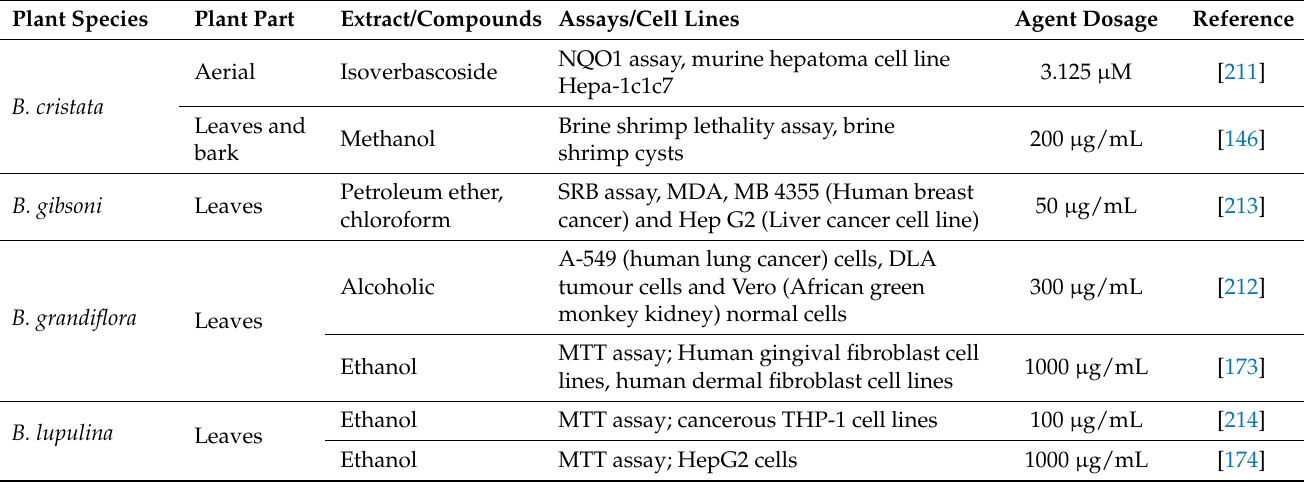
Table 6. Anticancer activities of extracts and isolated compounds from species within Barleria